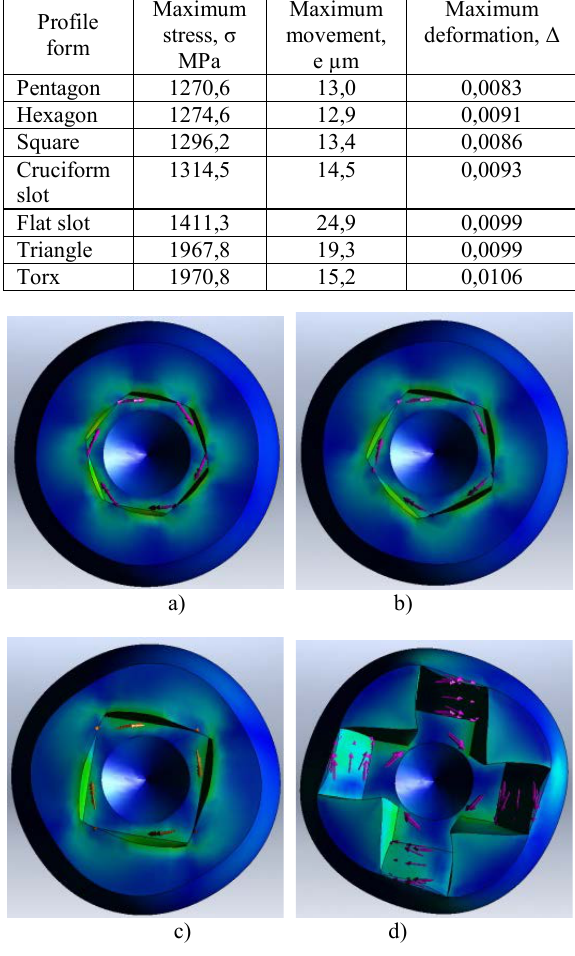
Table 1. Maximum v alues o f s tresses, d isplacements an d deformations using different standard